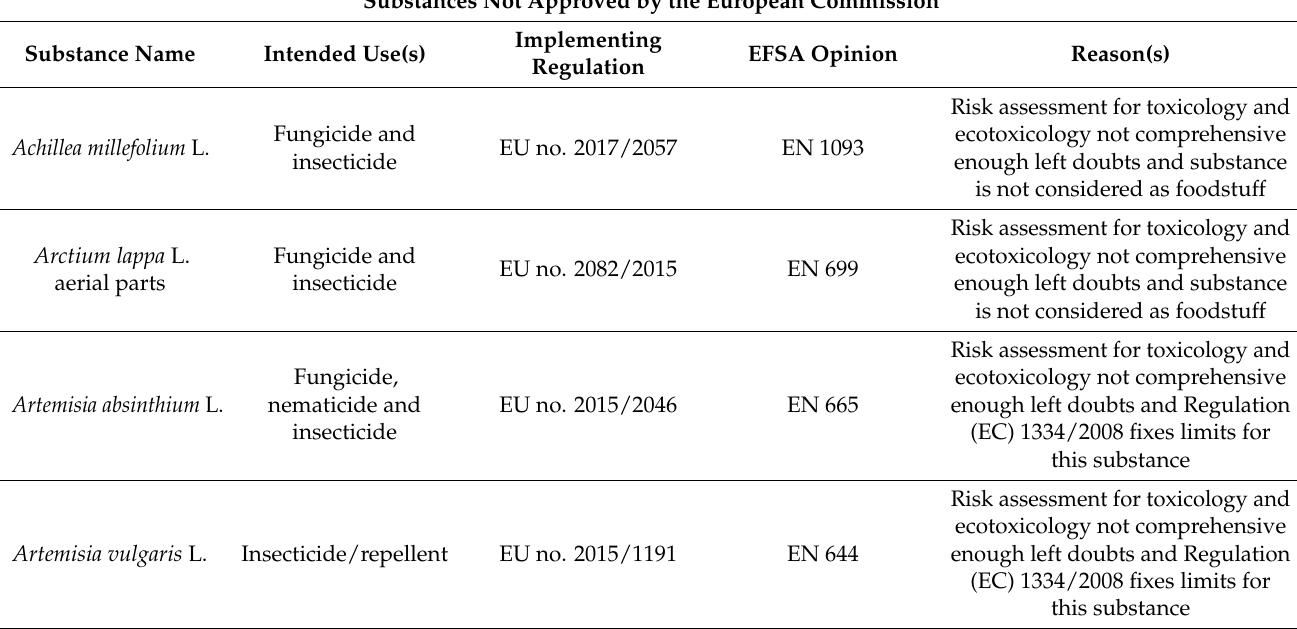
Table 4. Basic substance applications refused